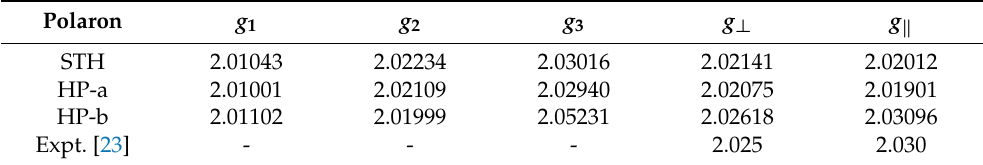
Table 1. Principal values of the calculated g tensor for self-trapped holes (STH) and the configurations HP-a and HP-b of defect-trapped holes, illustrated in Figure 1. The components perpendicular and parallel to the crystal z axis are compared to experimental values from Ref.